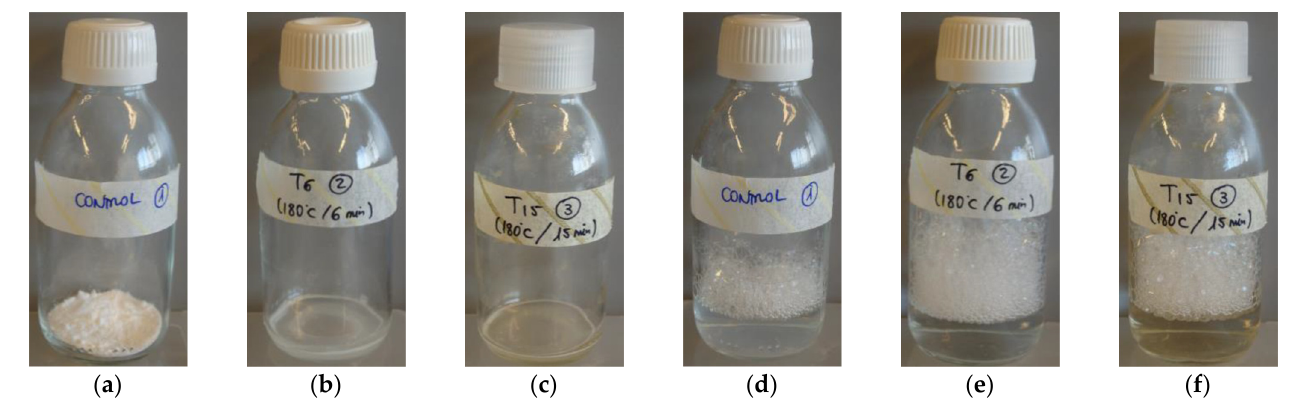
Figure 3. ( a ) Ethyl lauroyl arginate (LAE) without thermal treatment (control); ( b ) LAE heated at 180 °C for 6 min (T6)*; ( c ) LAE heated at 180 °C for 15 min (T15)*; ( d ) unheated LAE dissolved in ultrapure water (control); ( e ) LAE heated at 180 °C for 6 min dissolved in ultrapure water (T6); ( f ) LAE heated at 180 °C for 15 min dissolved in ultrapure water (T15). *Samples just removed from the oven (melting temperature about 58 °C).